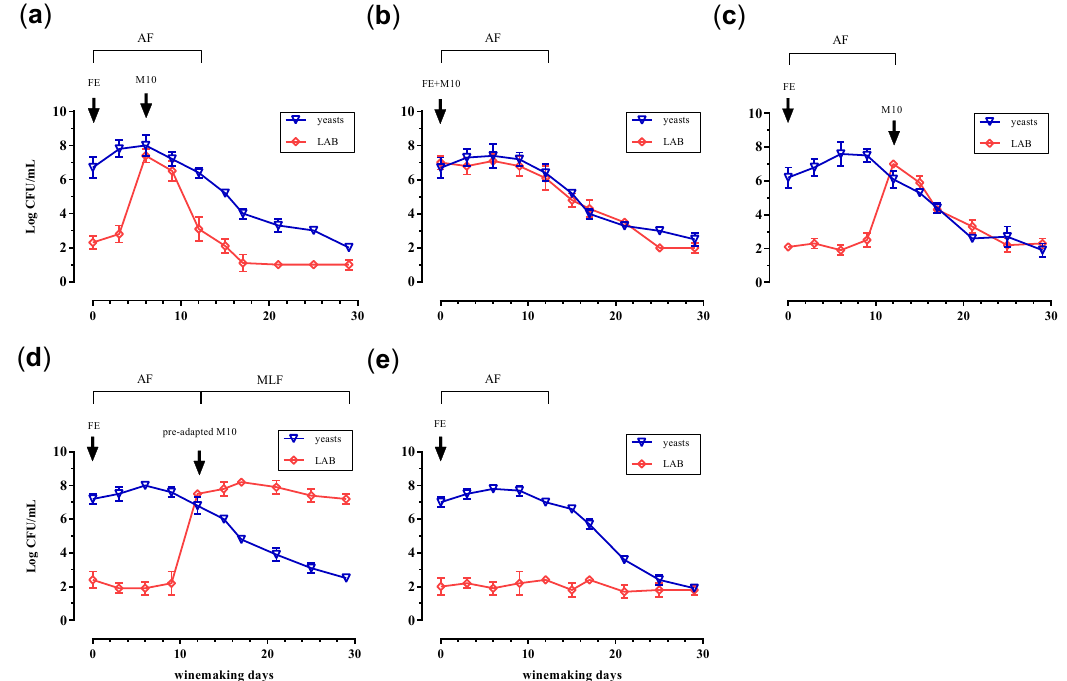
Figure 1. Trend of yeasts and LAB during the alcoholic (AF) and malolactic (MLF) fermentation of the 5 batches of Fiano grape must inoculated with S. cerevisiae FE at initial phase of the winemaking process and with Lb. plantarum M10 in accordance to di ff erent strategies of inoculum. ( a ) Batch inoculated with the strain M10 halfway through AF, late co-inoculum; ( b ) batch inoculated with M10 at the beginning of AF, early co-inoculum; ( c ) batch inoculated with Lb. plantarum M10 at the end of AF, sequential inoculum non-pre-adapted; ( d ) batch inoculated with M10 cells previously pre-adapted to acid and ethanol stress, sequential inoculum pre-adapted M10; ( e ) batch without inoculum of Lb. plantarum M10, control. The arrows indicate the point of M10 inoculum.